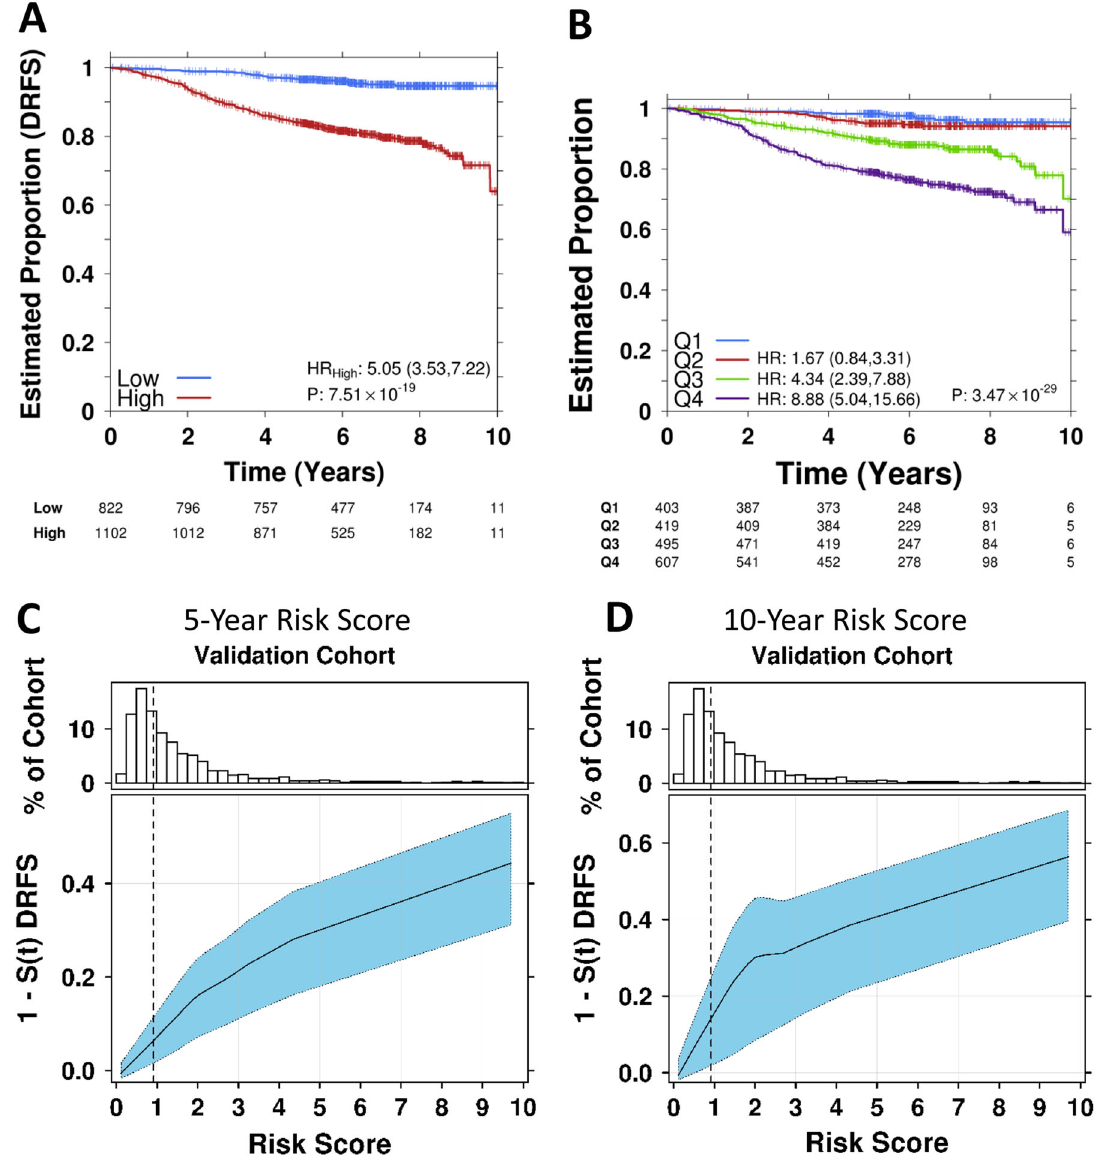
Fig. 1 Kaplan – Meier survival plots of the 95-gene residual risk signature in the TEAM pathology cohort. a Survival curves based on the prognostic model including nodal status applied to the validation cohort of patients receiving only endocrine therapy. b Risk score estimates shown in A grouped as quartiles with each group compared against Q1. Hazard ratios were estimated using Cox proportional hazards model and signi fi cance of survival difference was estimated using the log-rank test. c Distribution of patient risk scores in the TEAM Validation cohort showing the predicted 5 year recurrence probabilities ( solid line ) and 95% CI ( dashed lines ) as a function of patient risk score. Vertical dashed black line indicates training set median risk score. d Distribution of patient risk scores in the TEAM Validation cohort showing the predicted 10 year recurrence probabilities ( solid line ) and 95% CI ( dashed lines ) as a function of patient risk score. Vertical dashed black line indicates training set median risk